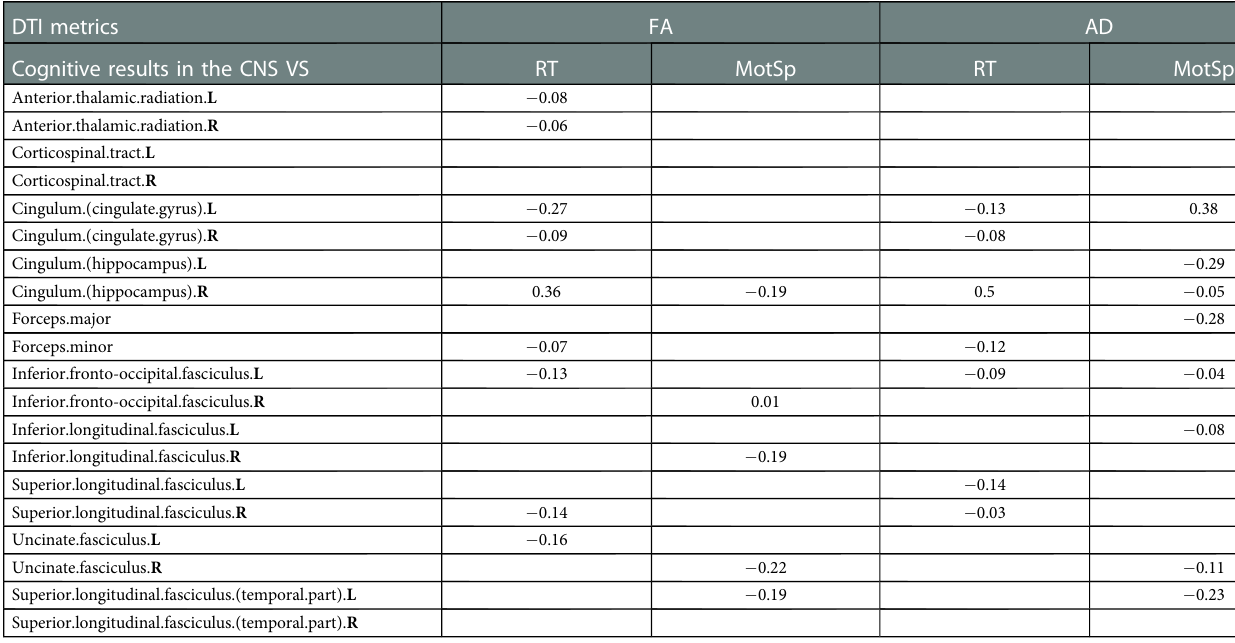
TABLE 2 Correlations of the DTI metrics of 20 white matter tracts and cognitive results. DTI metrics FA AD Cognitive results in the CNS VS RT MotSp RT MotSp Anterior.thalamic.radiation. L